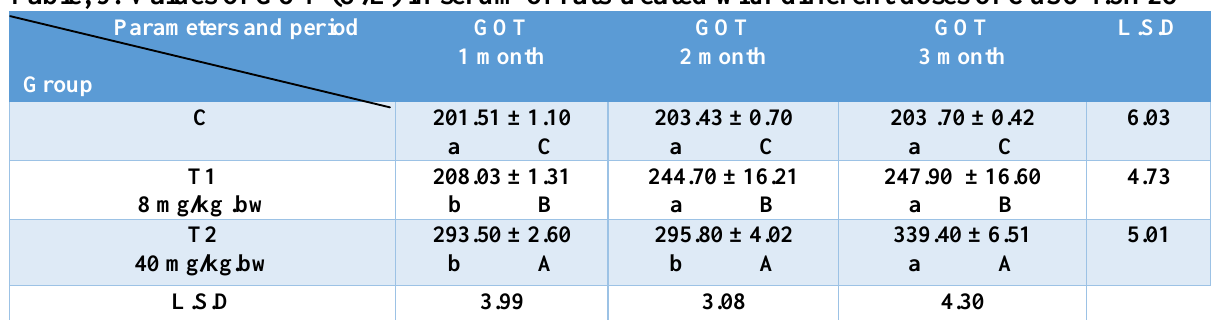
Table, 9: Values of GOT (U/L) in serum of rats treated with different doses of CuSO4.5H2O